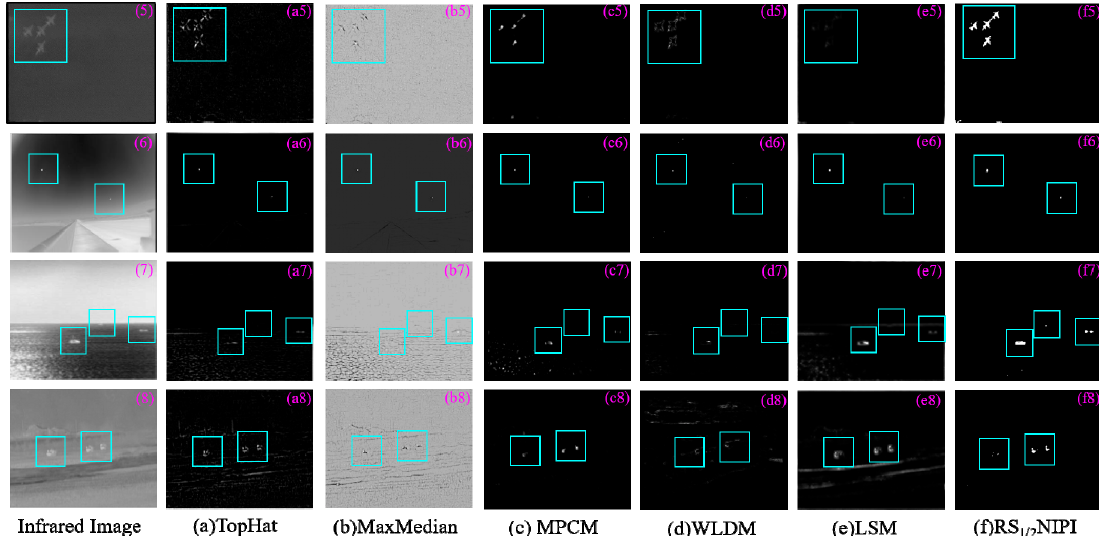
Figure 12. Representative multiple targets images from the datasets and the target images obtained by saliency-based methods and the proposed one. ( 5 – 8 ) are four representative multiple targets images from the tested datasets.